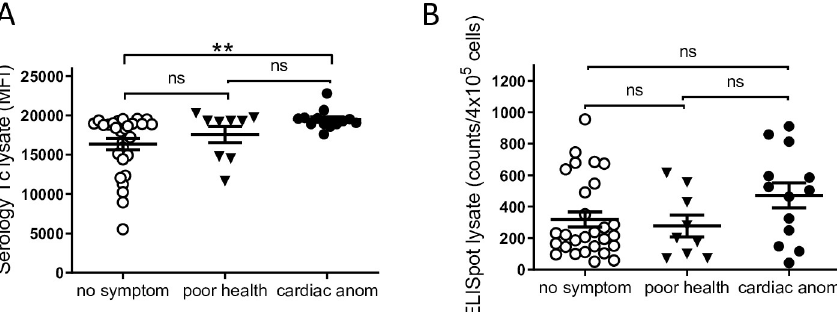
Fig 8. Macaques with cardiac anomalies show a higher antibody response. Comparison of antibody (A) and T cell responses (B) against T . cruzi lysate in seropositive macaques grouped in: animals displaying no symptoms (no symptom; n = 28), poor general health condition (poor health; n = 9) or cardiac anomalies (cardiac anom; n = 13). �� = p < 0.01 by Mann Whitney test.